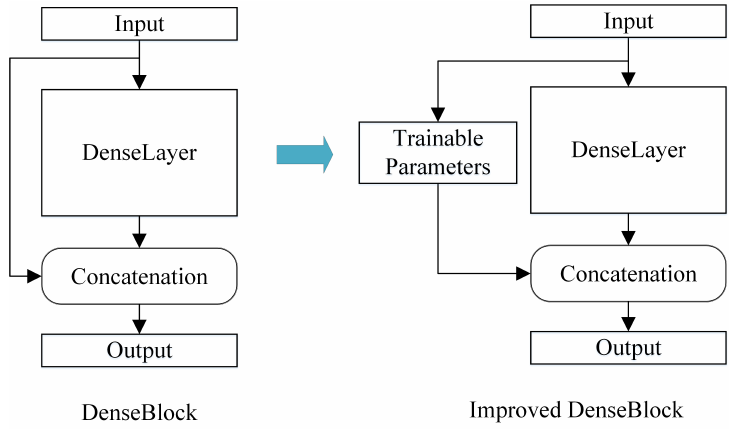
Figure 3. Improved dense block with trainable parameters for concatenation.